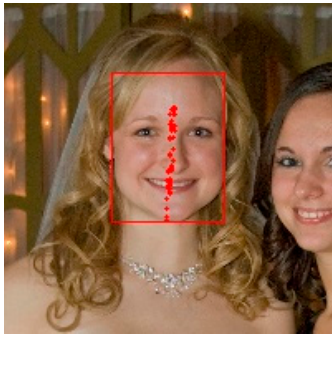
Figure 4. Facial symmetry.